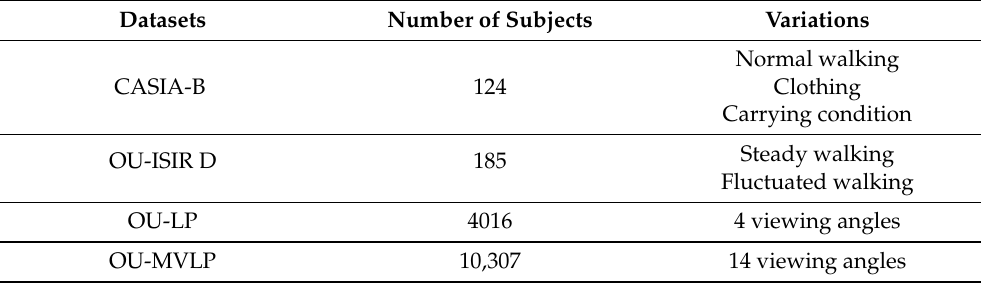
Table 5. Summary of Gait